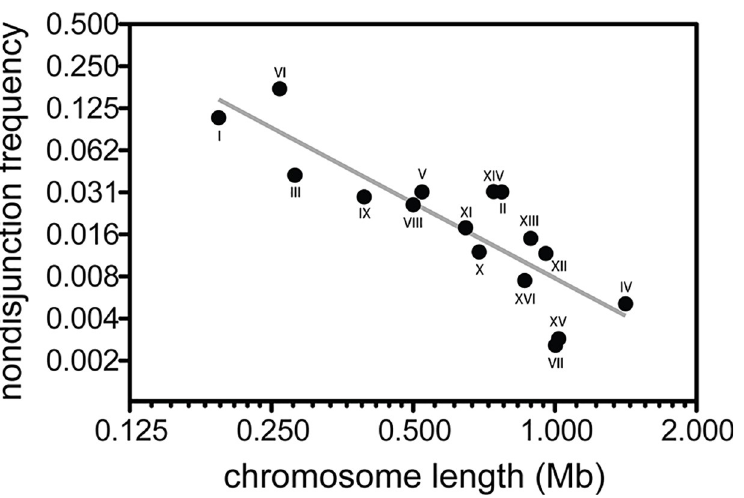
Fig 5. Short chromosomes fail to disjoin at higher rates than long chromosomes in an intraspecific S . paradoxus hybrid. Circles represent the nondisjunction frequency for each of the 16 homologous chromosome pairs in hybrids formed between the S . paradoxus strains N17 and N44. Underlying data can be found in S1 Data. Chromosome lengths represent the total amount of alignable sequence per chromosome pair between the genomes of each species. Length estimates were obtained using the complete genomes of S . paradoxus strains CBS432 (instead of N17) and N44 [22]. The alignable regions of these two genomes are 98.6% identical (11,358,261 identical sites out of 11,516,349 total sites). The grey line represents the line of best fit: log nondisjunction = − 2.12 − 1.79(log